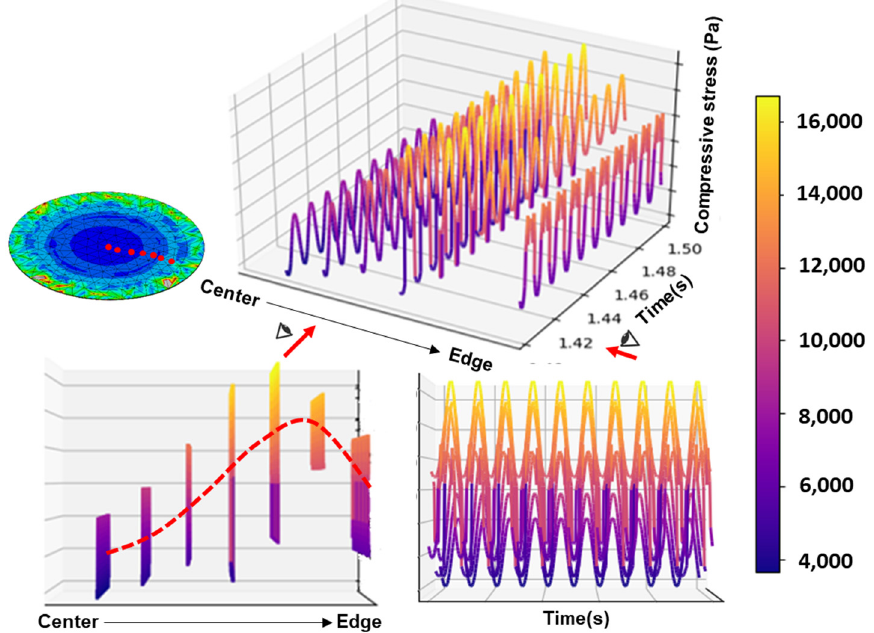
Figure 9. Axial compressive stress nephogram on the pressboard of group TEM11 at the moment of 1.05 s.